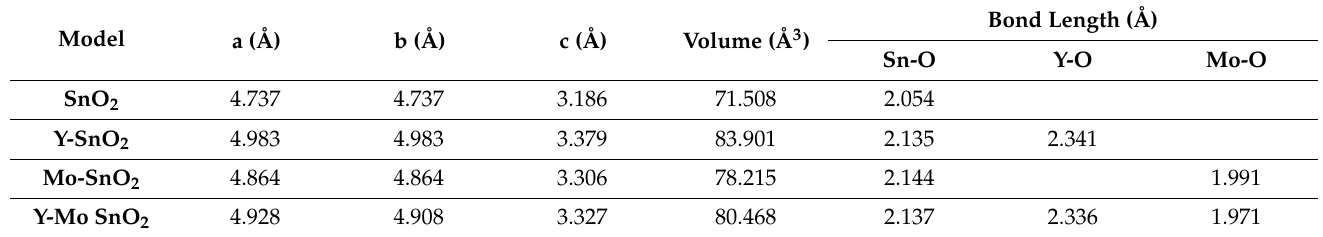
Table 2. Cell parameters.